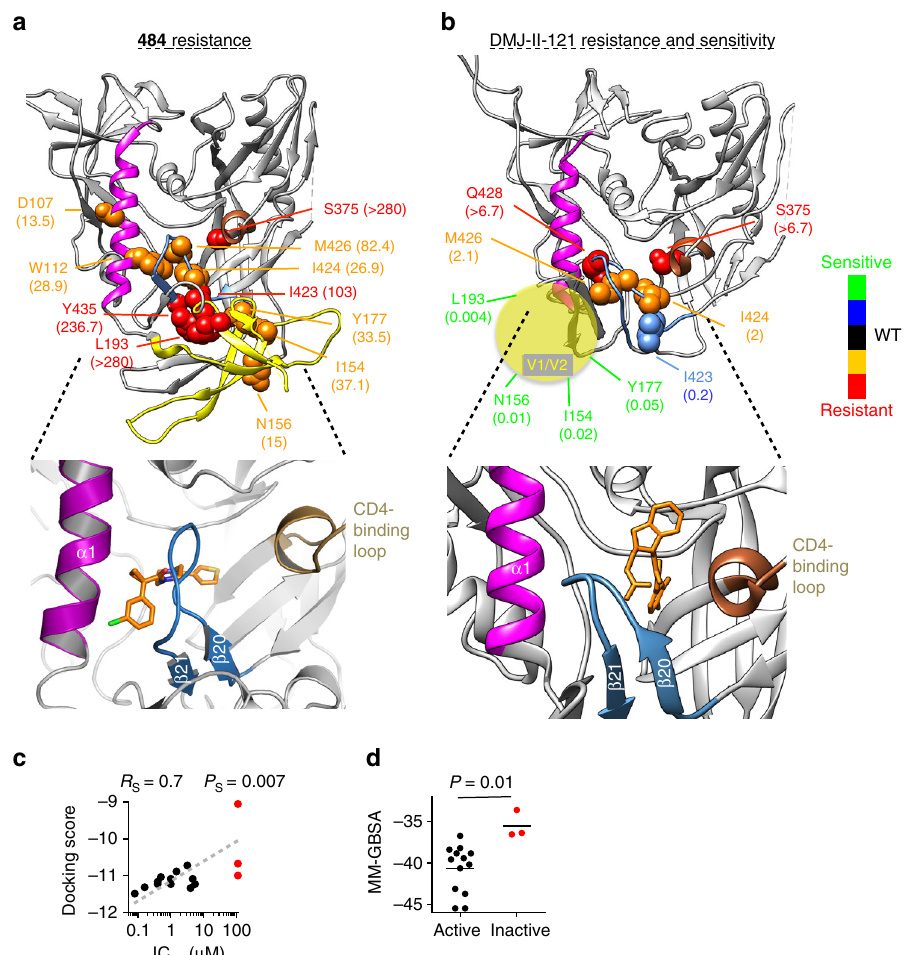
Fig. 2 Genetic analysis and binding sites of chemical probes of HIV-1 Env conformation. a , b Amino acid residues associated with resistance or hypersensitivity to 484 and the CD4-mimetic compound DMJ-II-121 are shown on structures of the HIV-1 BG505 soluble gp140 (sgp140) SOSIP.664 glycoprotein. We used an Env structure without sCD4 (Protein Data Bank (PDB) 4TVP) 30 for mapping 484 susceptibility, and a CD4-bound Env conformation (PDB 5THR) 22 for mapping DMJ-II-121 susceptibility. The CD4-bound Env model represents a fi t of the sgp140 SOSIP.664 structure to an 8.9-Å-resolution cryo-EM density map; the model lacks the V1/V2 region, which is schematically represented (yellow sphere). In comparison with the structure of sgp140 SOSIP.664 without sCD4, the density map shows a large CD4-induced movement of the V1/V2 region of gp120 22 . The color code key indicates the level of resistance for the speci fi ed residues. The ratio of the mutant to wild-type HIV-1 JR-FL IC 50 values (fold change) for resistant and hypersensitive HIV-1 mutants is shown in parentheses; the IC 50 value of each Env mutant is shown in Supplementary Table 4. Infectivity of the mutant HIV-1 JR-FL viruses was not signi fi cantly affected by the amino acid changes except for two changes (I154A and N156A). The expanded image in the lower panel of a shows a docking pose of the 484 compound in the crystal structure of the HIV-1 BG505 soluble gp140 SOSIP.664 component of the complex with BMS-626529 28 . The expanded image in the lower panel of b shows the crystal structure of DMJ-II-121 in complex with the HIV-1 C1086 gp120 core (PDB ID 4I53). 27 c , d The relationship between either the docking scores ( c ) or docking energy ( d ) and the antiviral activity of a panel of 484 derivatives was used to assess the reliability of the docking in a . The dashed line indicates the linear trend between the docking score and IC 50 values. The scores and derivatives analyzed are shown in Supplementary Table 5. As a control, the BMS-626529 compound was docked into the crystal structure (Supplementary Fig. 4). Red color, non-active compounds (IC 50 > 112 μ M). R s , Spearman coef fi cient; P S , Spearman P value; P , t test P the HIV-1 BG505 soluble gp140 (sgp140) SOSIP.664 Env were unsuccessful, but parallel efforts determined the structure of other conformational blockers, BMS-806 and BMS-626529, in a com- plex with this Env trimer 28 . We used the crystal structure of HIV- 1 BG505 sgp140 SOSIP.664-BMS-626529 (after removing the bound BMS-626529) to model the binding of 484 . Docking